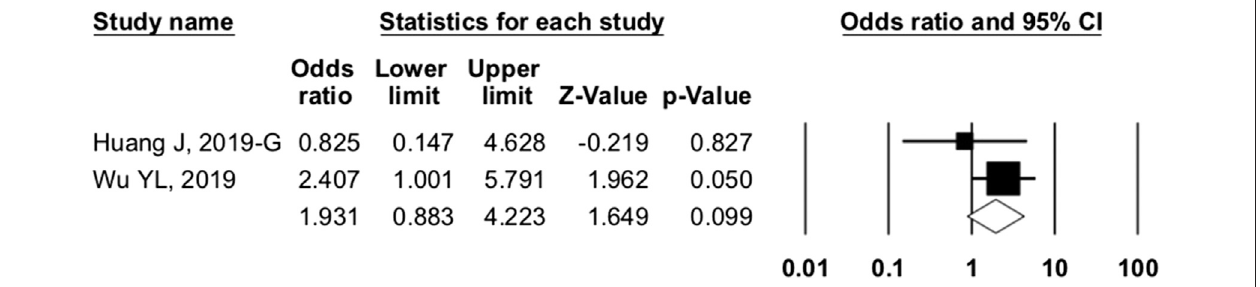
Frontiers in Pharmacology |